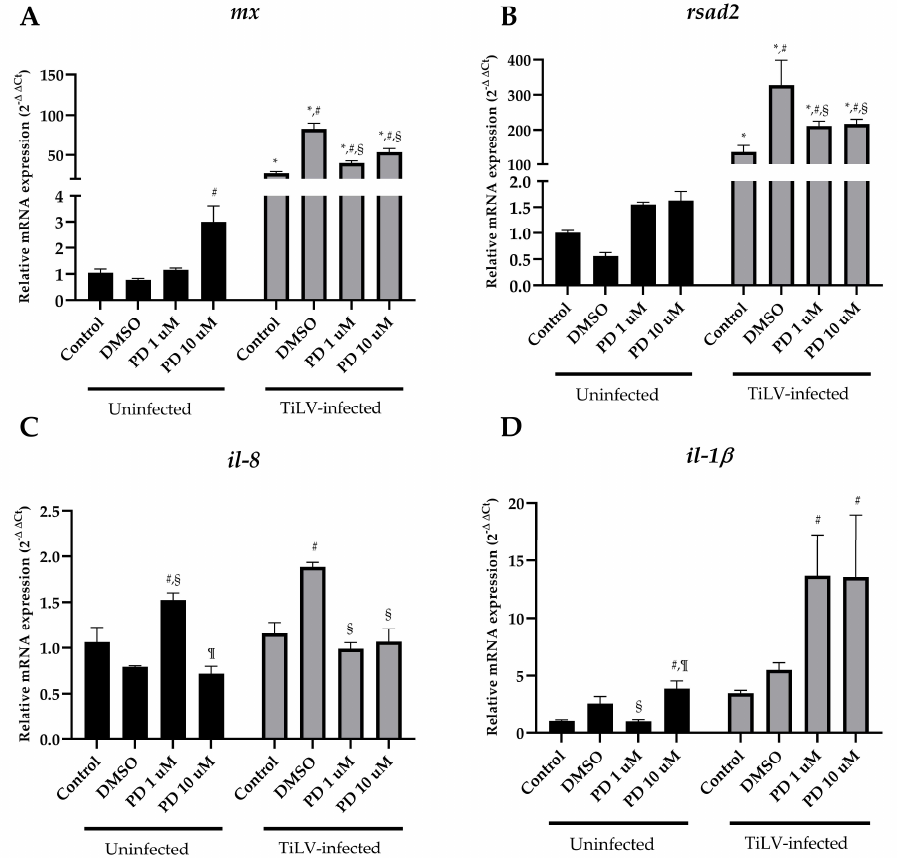
Figure 6. Relative expression of immune-related genes in TiB cells treated with TiLV and PD ( A ) mx , ( B ) rsad2 , ( C ) il-8 and ( D ) il-1β genes in uninfected and TiLV-infected TiB cells following four conditions: control cells, 1% DMSO and PD at 1 and 10 µM (n = 3 each). The data are demonstrated as means ± SEMs. * p < 0.05 vs. uninfected cells, # p < 0.05 vs. control, § p < 0.05 vs. DMSO, ¶ p < 0.05 vs. PD 1 µM.